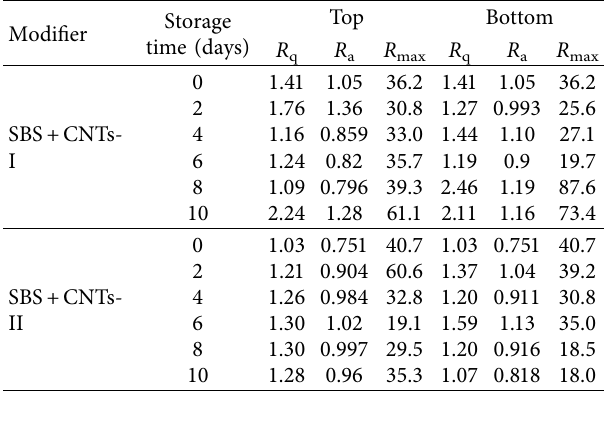
Figure 17: The phase diagram of SBS+CNTs-II with increasing storage time. Table 4: The surface roughness of samples with different storage